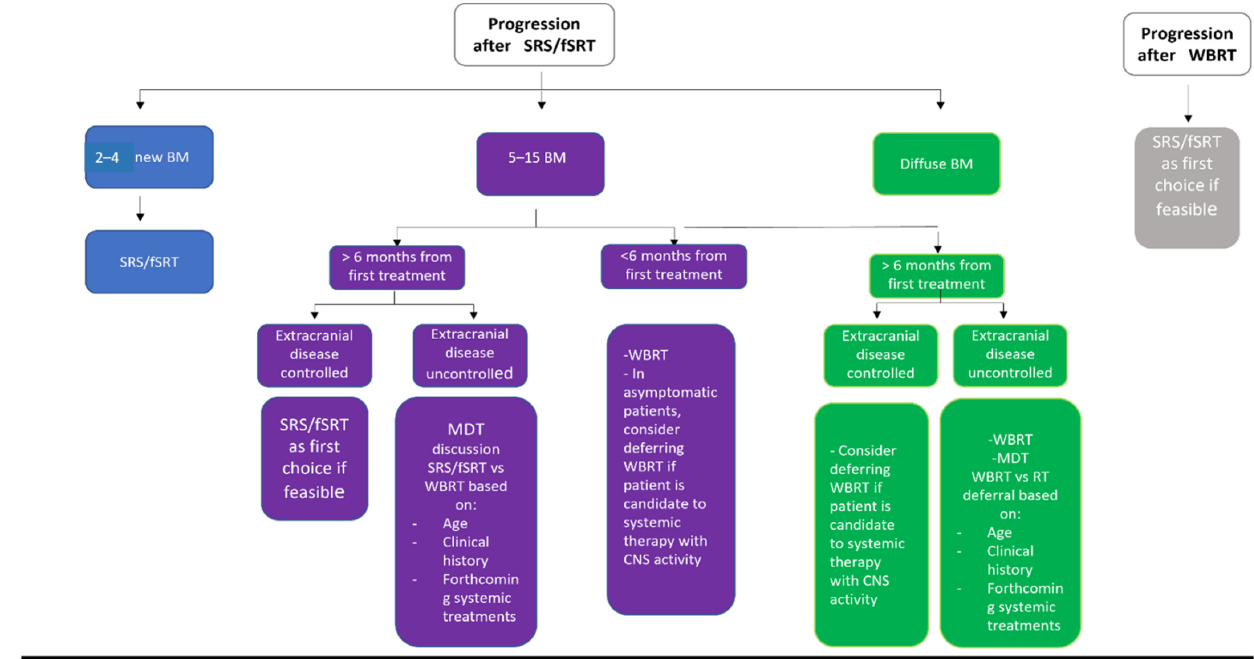
Figure 2. Proposed algorithm for newly diagnosed HER2 BMs.